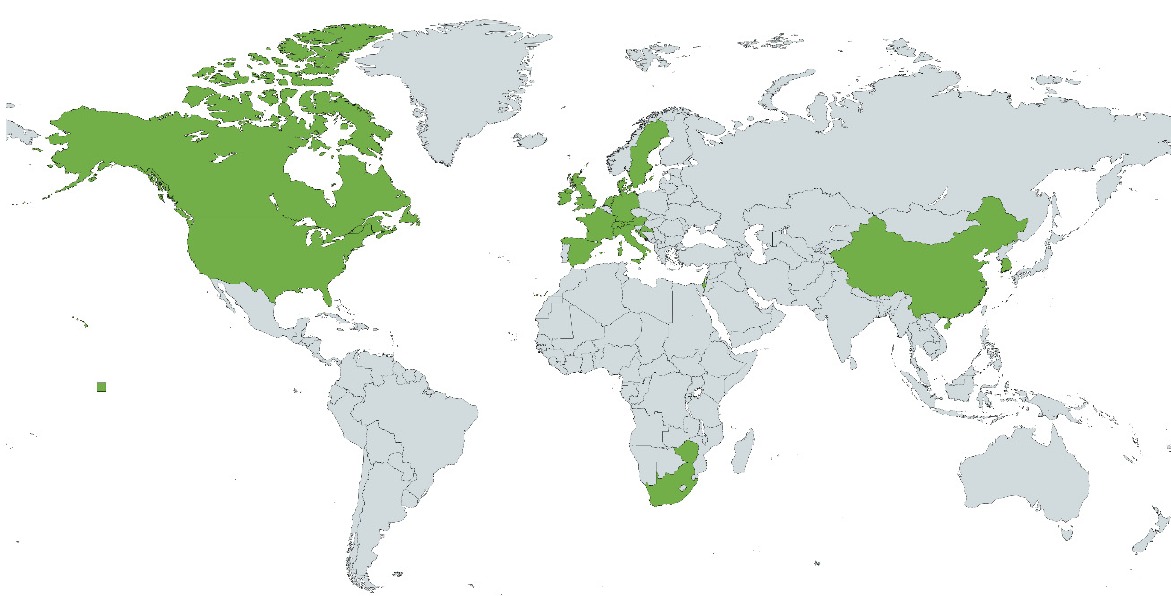
Figure 3. Geographical distribution of practitioners who shared industry challenges (green), based on [62]. Image created with mapchart.net, CC-BY-SA.